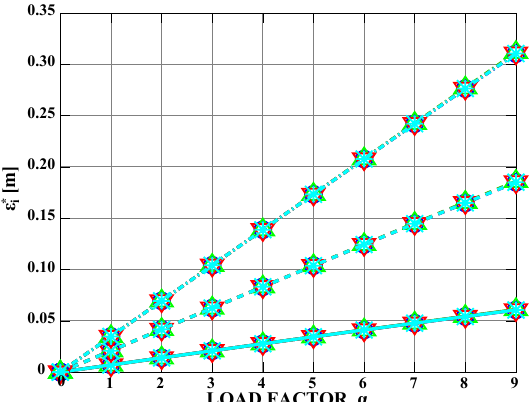
Figure 9. Components of the stretch vector: ε ∗ (dashed line), ε ∗ (dash-dotted line). Case 2a ( (cid:13) ), 2b ( 4 ), 2c ( 5 ), 3 2d ( ∗ ).